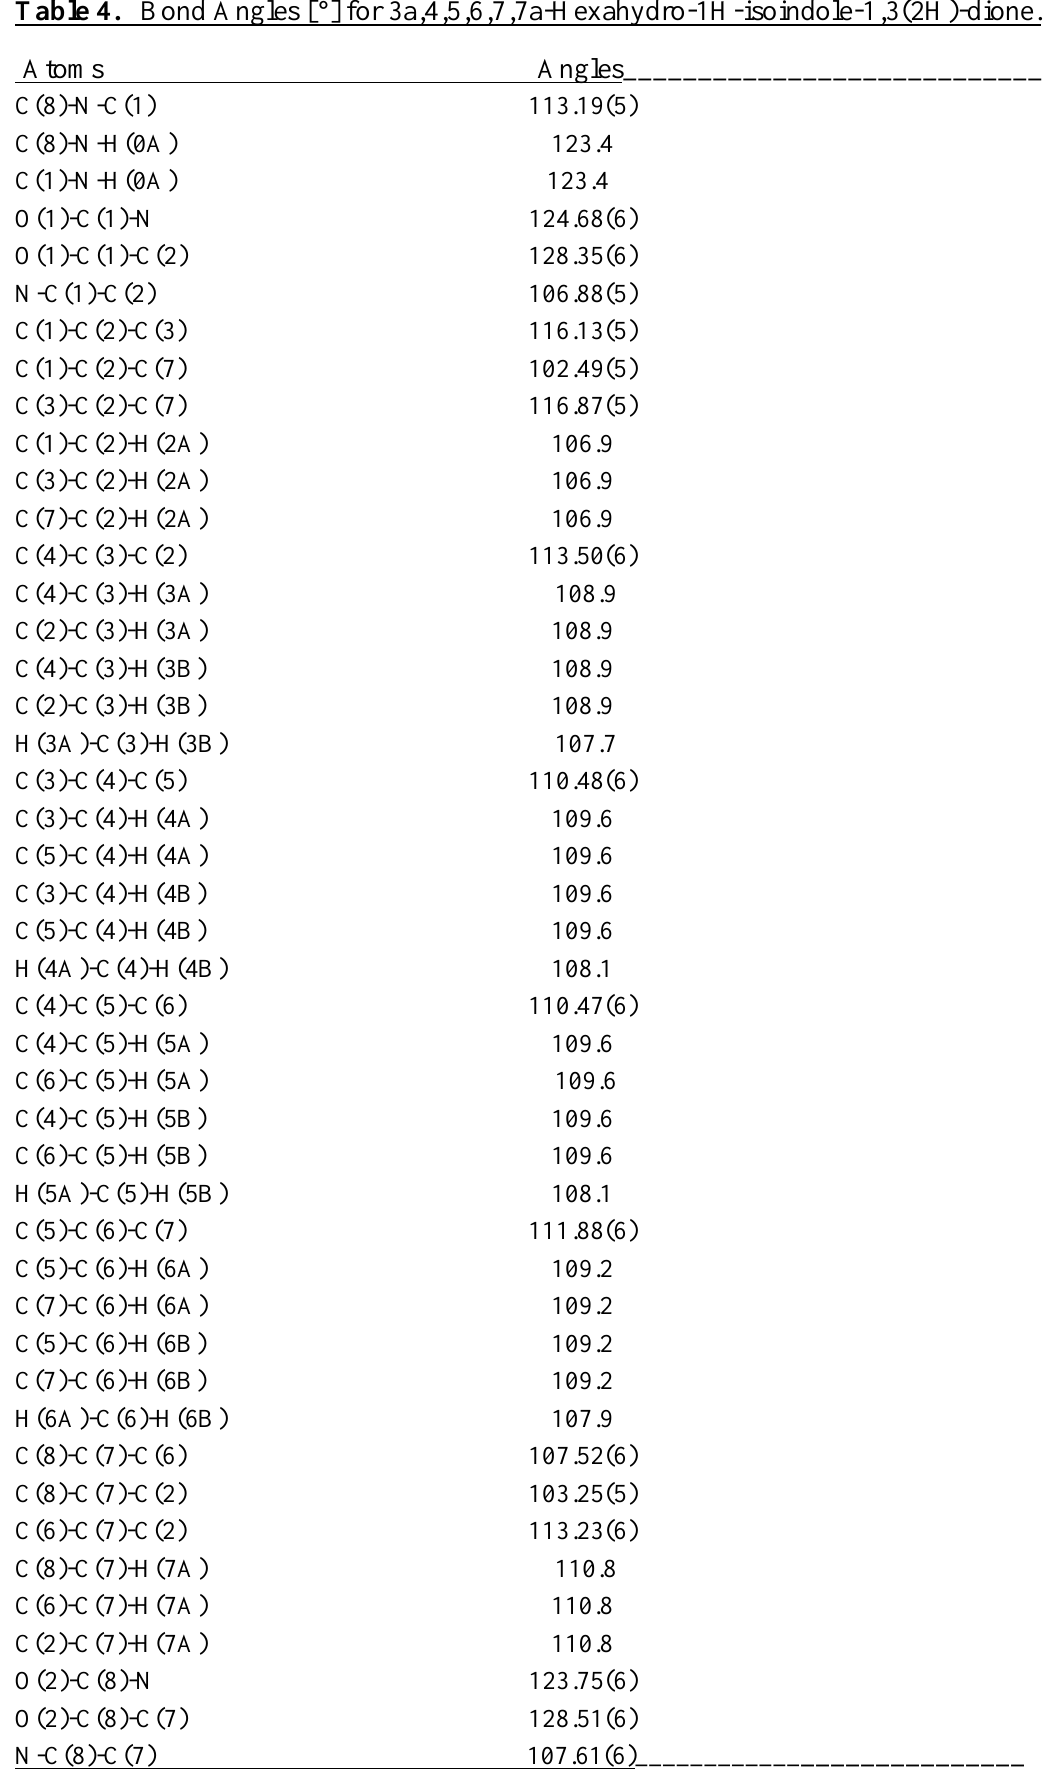
Table 4. Bond Angles [°] for